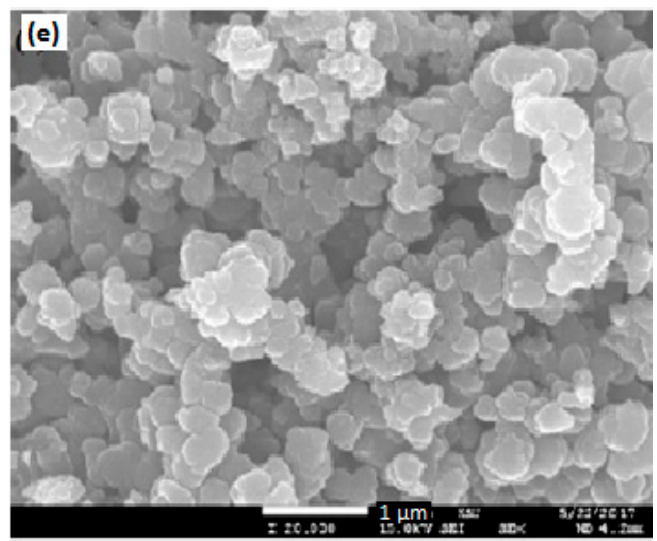
Figure 8. SEM images of ( a ) PPy/1% BaTiO 3 , ( b ) PPy/2% BaTiO 3 , ( c ) PPy/3% BaTiO 3 , ( d ) PPy/4% BaTiO 3 and ( e ) PPy/5% BaTiO 3 .